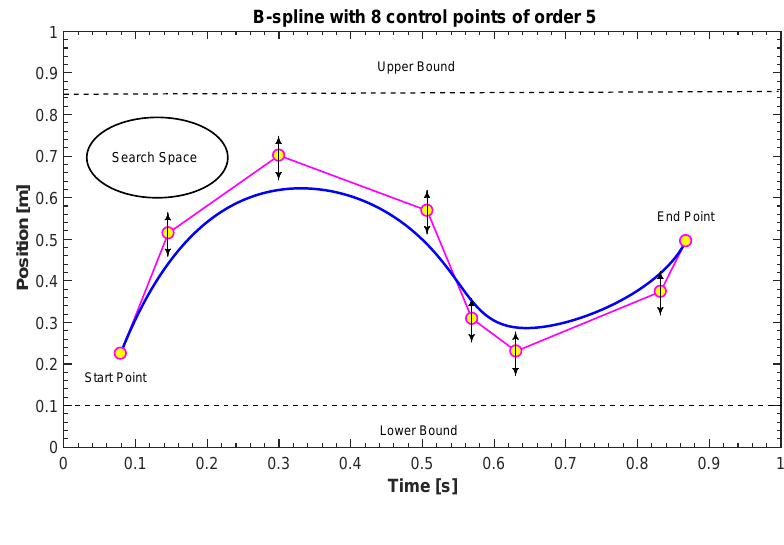
Figure 2. Evolution of the